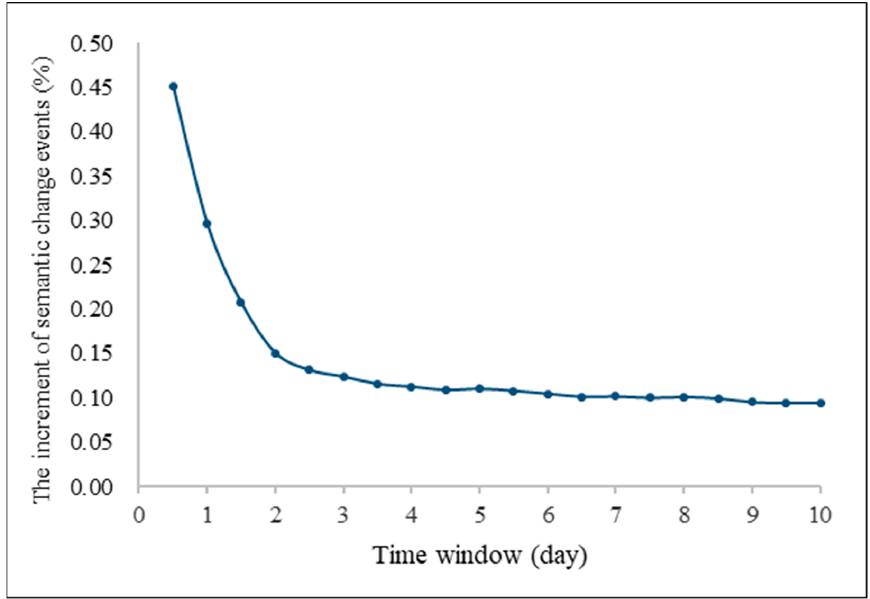
ISPRS Int. J. Geo-Inf. 2022 , 11 , x FOR PEER REVIEW Figure 4. The average increment of semantic change events for different time windows.